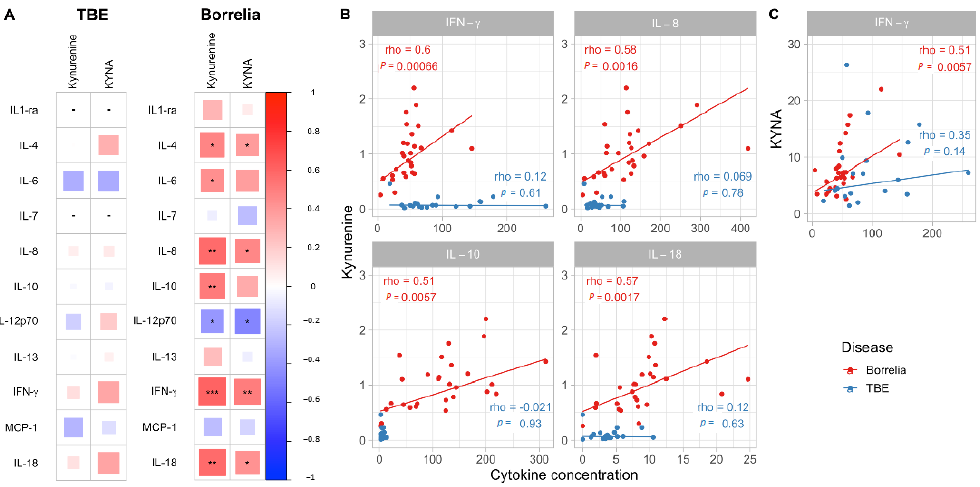
Figure 3. ( A ). Heatmaps of Spearman correlation coefficients between CSF tryptophan metabolites kynurenine, kynurenic acid (KYNA) and CSF cytokines in children with neuroborreliosis (NB, n = 28) and tick-borne encephalitis (TBE, ( n = 22). Positive correlations (blue), Negative correlations (red). ( B ) Correlation between concentrations of kynurenine and IFN- γ , interleukin (IL)-8, IL10 and IL-18 and ( C ) Correlation between concentrations of KYNA and interferon (IFN)- γ in children with NB (red circles) and TBE (blue circles). Spearman rank correlation analysis (rho). Alpha threshold is set to *** p < 0.001, ** p < 0.01, * p <